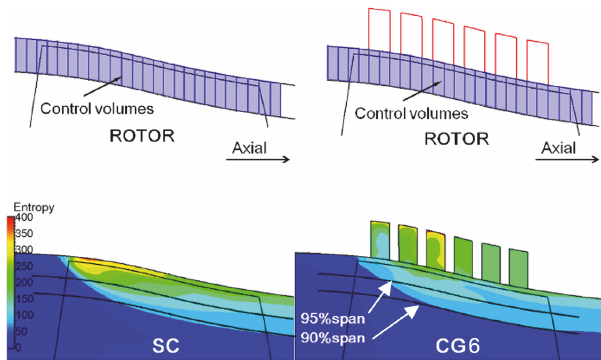
Figure 12: The installment of control volumes ([16]). Figure reproduced from NAN et al. (2014).